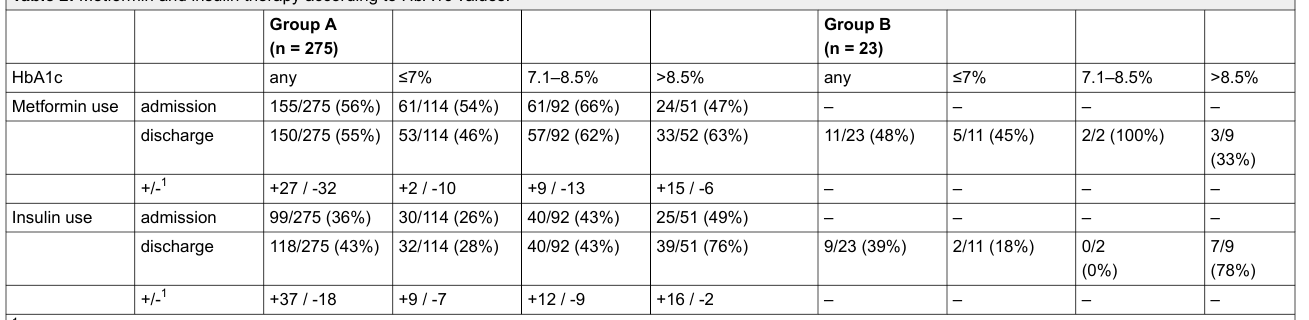
Table 2: Metformin and insulin therapy according to HbA1c